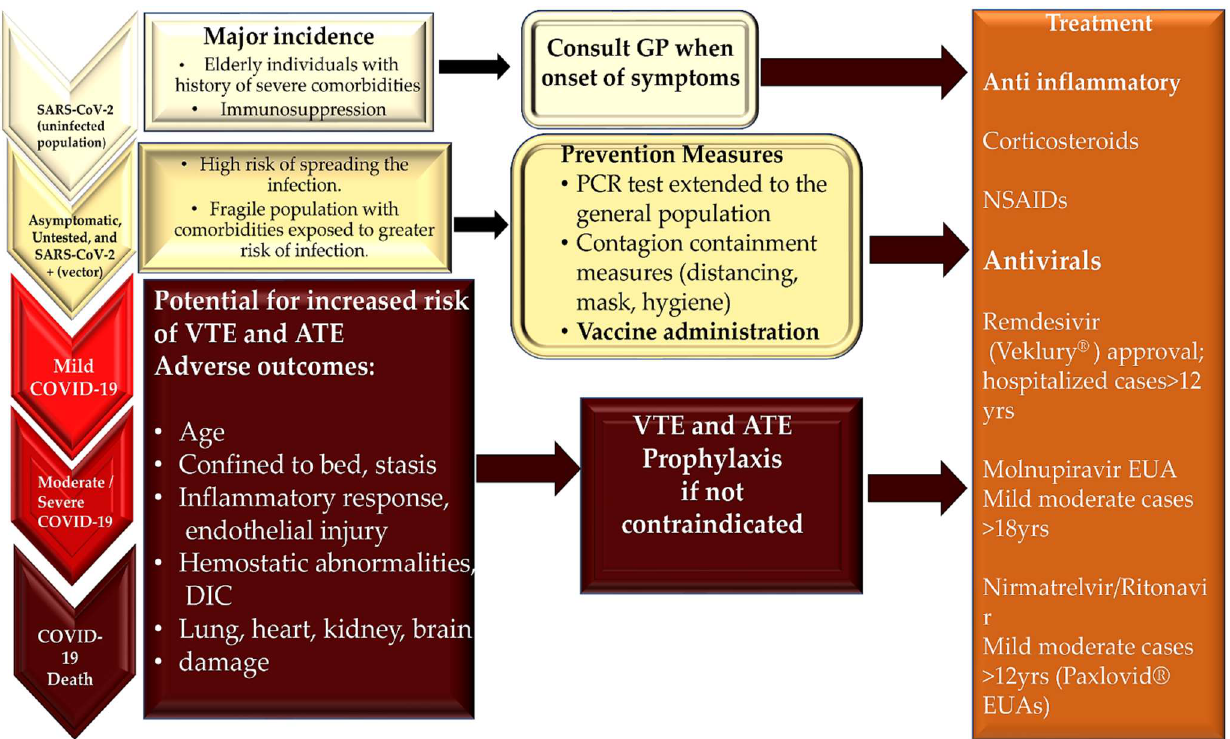
Figure 6. Patients with COVID-19 have different clinical evolutions. Their treatment options depend on the diagnosis of the complications that occur. Clinical variability in the manifestation of COVID-19 has been observed in the population developing SARS-CoV-2 infections. Myocarditis occurs rarely compared to thrombosis; however, both are driven by inflammation. The inflammatory response increases with age and bed rest, which is more frequent in severe COVID-19, and may contribute to thrombosis and adverse events resulting from multiorgan involvement. The FDA’s timeline for the approval of antivirals and the EUA’s process timeline. Veklury ® EUA’s process was formalized in January 2020. Its final approval occurred in October 2020. Molnupinavir and Paxlovid ® EUA’s process followed in December 2021. Abbreviations: ATE, arterial thromboembolism; COVID-19, coronavirus disease 2019; DIC, disseminated intravascular coagulation; EUA, Emergency Use Authorization; FDA, Food and Drug Administration; NSAIDs, non-steroidal anti-inflammatory drugs; SARS-CoV-2, severe acute respiratory syndrome coronavirus 2; and VTE, venous thromboembolism.